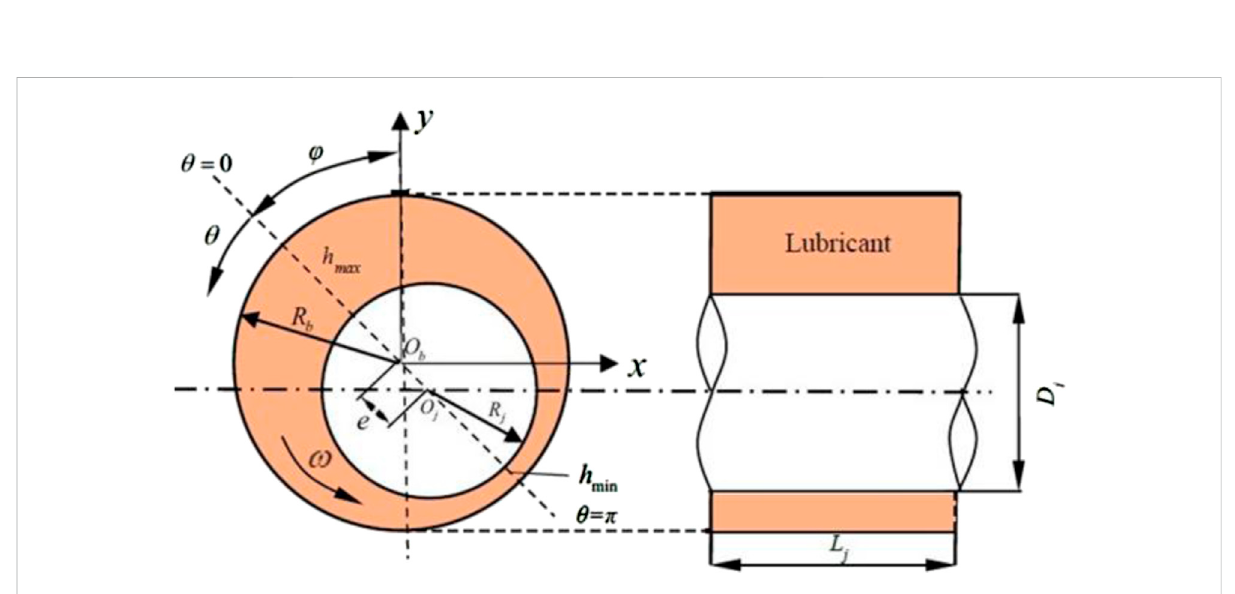
FIGURE 1 Nomenclature of journal